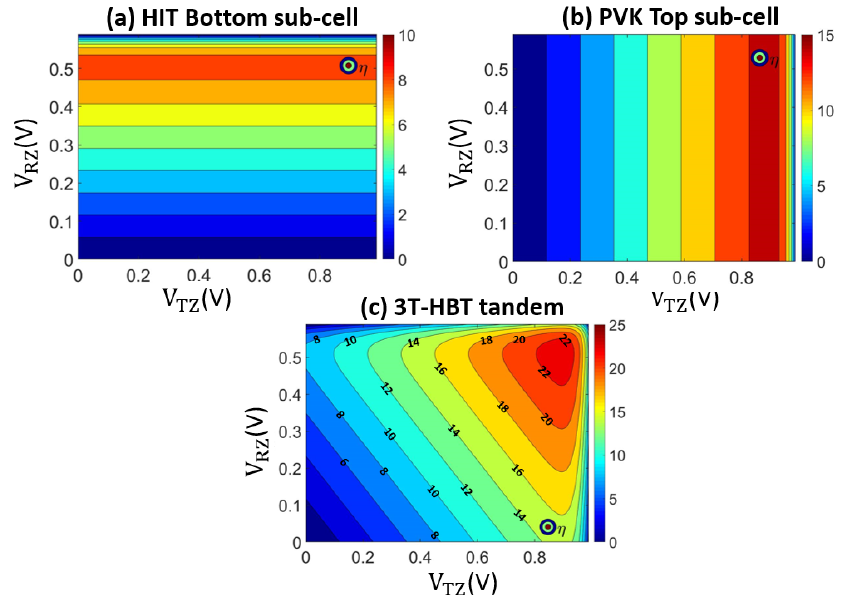
Figure 7. ( a ) Efficiency as a function of the TZ and RZ voltages for: ( a ) HIT bottom sub-cell; ( b ) PVK bottom sub-cell; ( c ) 3T-HBT